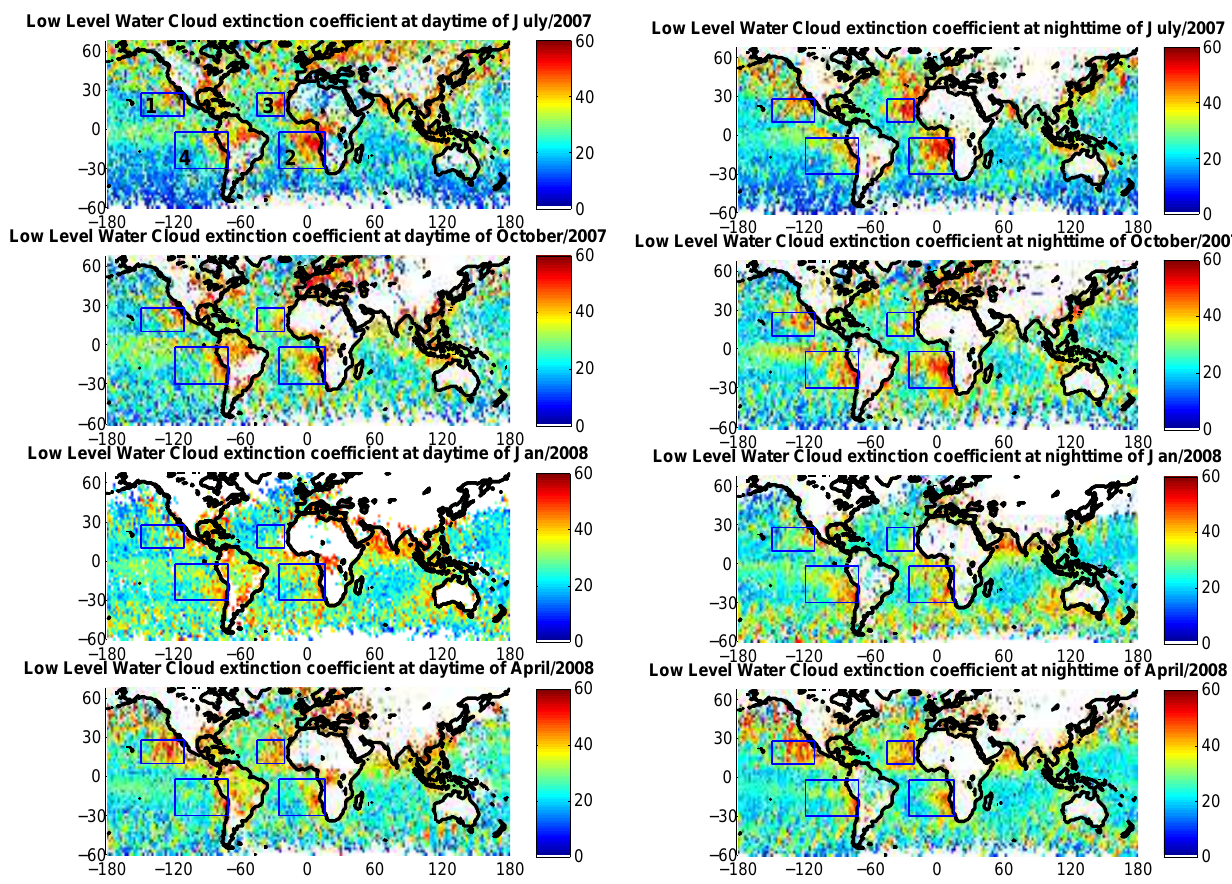
Fig. 6. The global distribution (2 ◦ by 2 ◦ ) of Low level water cloud mean extinction coefficient at different months derived from the slope method at day (left) and night(right). Sc regions are marked by blue boxes and numbered in Fig. 6. They are: 1, Californian; 2, Namibian; 3, Canarian; 4, Peruvian.